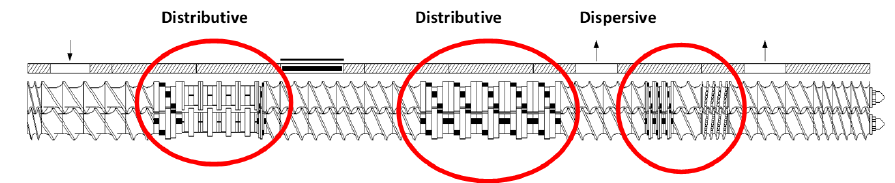
Figure 1. Extruder screw configured profile with distributive and dispersive mixing